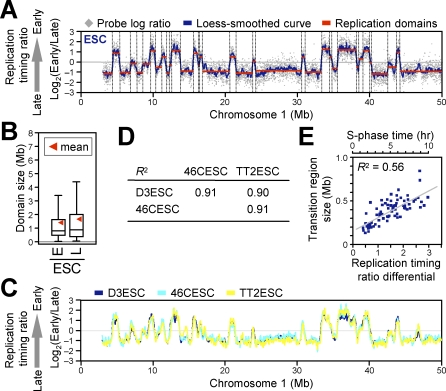
Replication Domain Structure and Its Conservation between Three Independent mESC Lines(A) Identification of replication domains (red lines) and their boundaries (dotted lines) by a segmentation algorithm [32].(B) Box plots of early (E; log ratio > 0) and late (L; log ratio < 0) replication domain sizes. Horizontal bars represent the 10th, 25th, 50th (median), 75th, and 90th percentiles, respectively.(C and D) Three different mESC lines (D3, 46C, and TT2) showed remarkably similar replication domain organization, as revealed by visual inspection of a segment on Chromosome 1 (C) and high Pearson R
2 values for pair-wise comparisons (D).(E) A scatter plot of replication-timing differential versus physical distance (Mb) between the ends of 75 randomly chosen pairs of adjacent replication domains (replication-timing transition regions) from Chromosomes 2, 11, and 16 (25 each) revealed a positive correlation with a slope that is consistent with mammalian replication fork speeds. A time scale is provided, based on the assumption that replication-timing ratio difference of three roughly corresponds to an approximately 10-h S-phase.